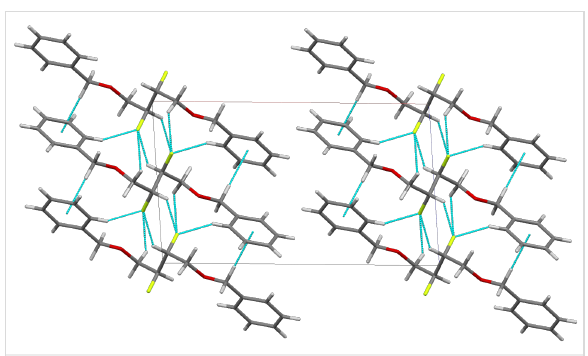
Examination of the Cambridge Structural Database [49]